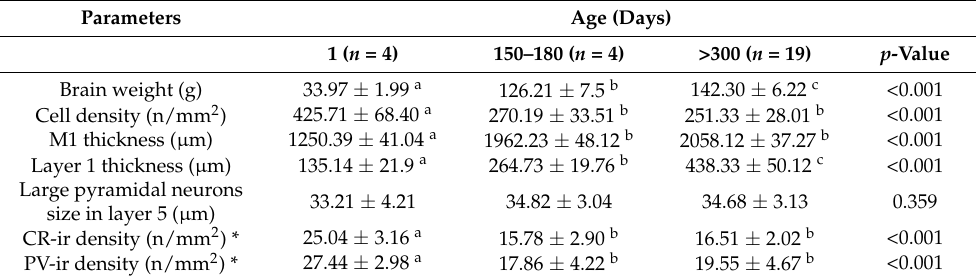
Table 3. Data concerning the primary motor cortex of the female domestic pig Sus scrofa domesticus .